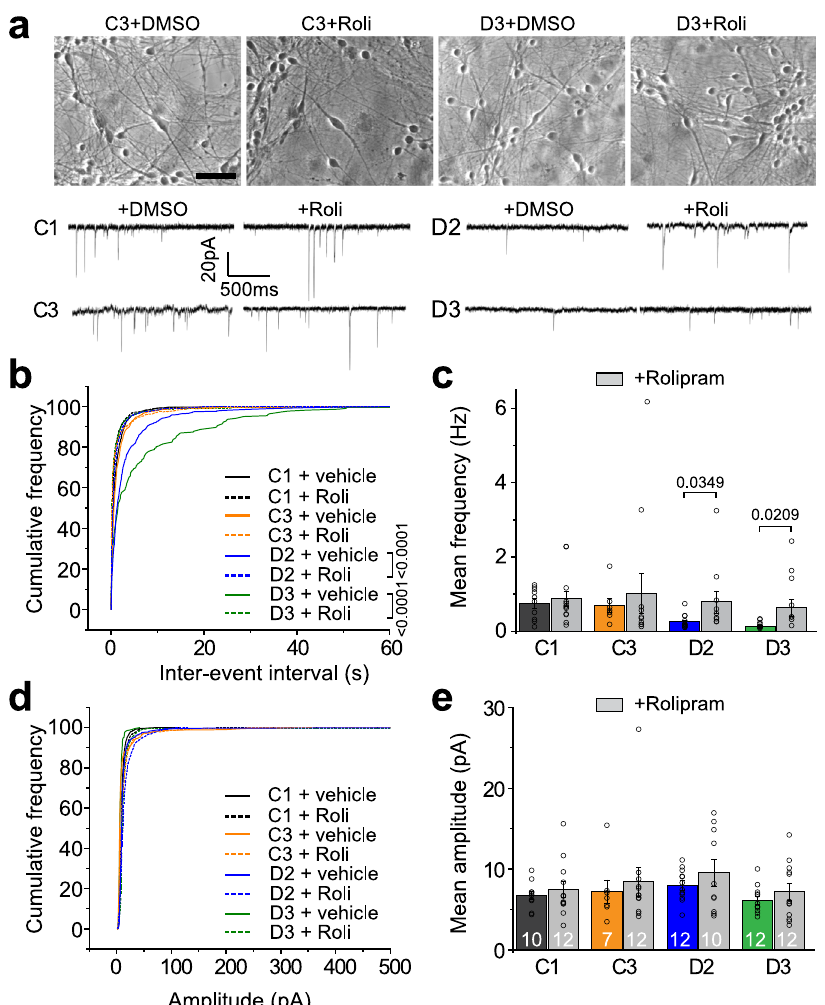
Fig. 2 Functional rescue of synaptic defects of DISC1 mutant neurons. a Sample images of 6-week-old human neurons differentiated from iPSC lines co- cultured with astrocytes (top) and sample whole-cell voltage-clamp recording traces of excitatory spontaneous synaptic currents (SSCs), with the treatment of vehicle or Rolipram (Roli, 100 nM). Scale bar, 50 μ m. The representative images were taken from 3 independent experiments. b – c Cumulative distribution plots of SSC inter-event intervals ( b , 4 weeks old neurons) and quanti fi cation ( c , 6 weeks old neurons) showing rescue of reduced SSC frequency of DISC1 mutant neurons after Rolipram treatment. Values in c represent mean ± s.e.m. ( n = 3 independent differentiation cultures; cell number 7 to 12 for each condition; Kolmogorov – Smirnov test for b , and One-way ANOVA for c with p values indicated). d – e Rolipram treatment has no effect on the amplitude of SSCs. Cumulative distribution plots of SSC amplitude ( d , 4 weeks old neurons) and quanti fi cation ( e , 6 weeks old neurons). The same neurons as in b – c were examined. Values in e represent mean ± s.e.m. ( n = 3 independent differentiation cultures; cell number 7 to 12 for each condition). Source data are provided as a Source Data fi